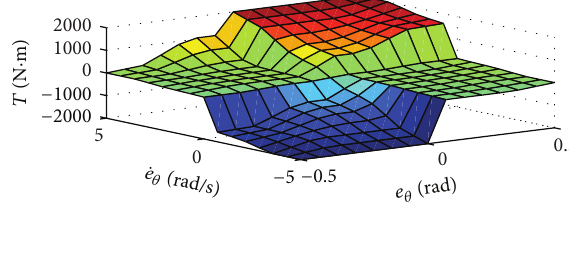
Figure 3: The surface established versus rules.